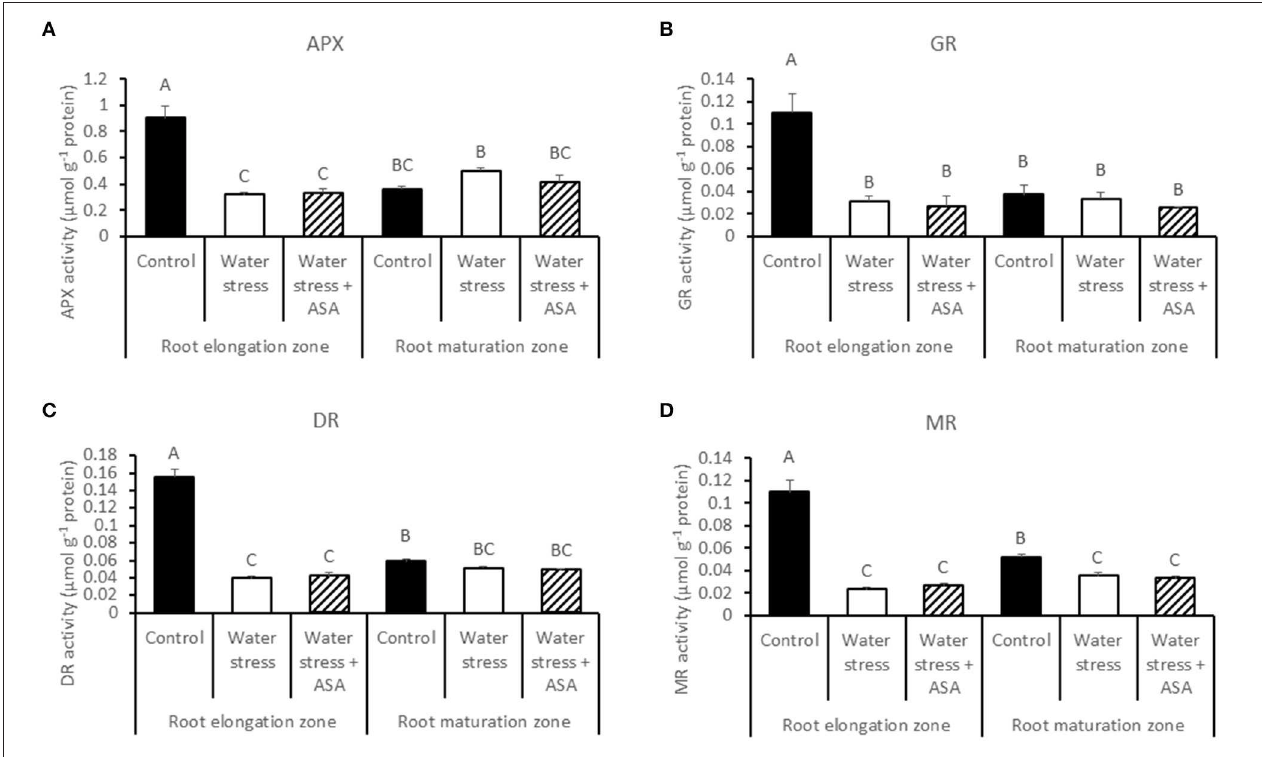
FIGURE 7 | Activity of ascorbate peroxidase (APX) (A), glutathione reductase (GR) (B), dehydroascorbate reductase (DR) (C), and monodehydroascorbate reductase (MR) (D) in tall fescue roots exposed to non-stress control, water stress, and water stress with ASA treatment. The data represent mean ± SE ( n = 4 replicated pots of plants and each pot with multiple plants). Columns marked with the same letter are not significantly different at p < 0.05 .